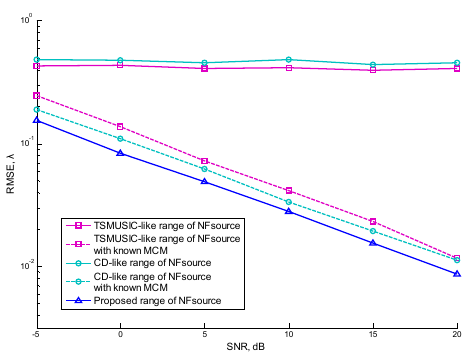
Figure 7. ( a ) RMSEs of the DOA estimates versus signal noise ratio (SNR); ( b ) RMSEs of the DOA estimates versus SNR with known MCM.